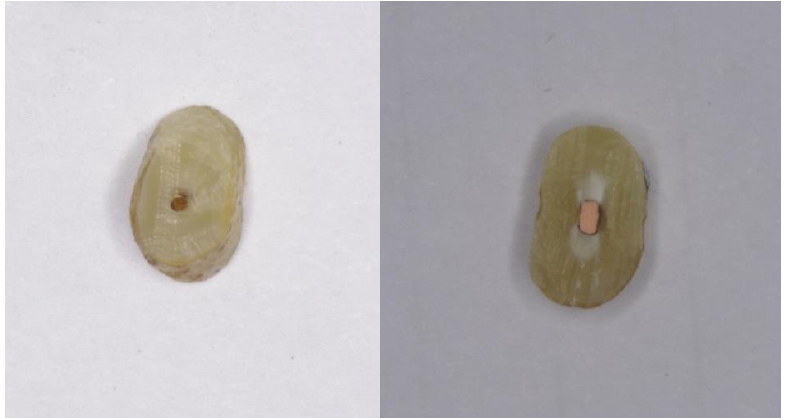
Figure 6. samples with removed smear layer.